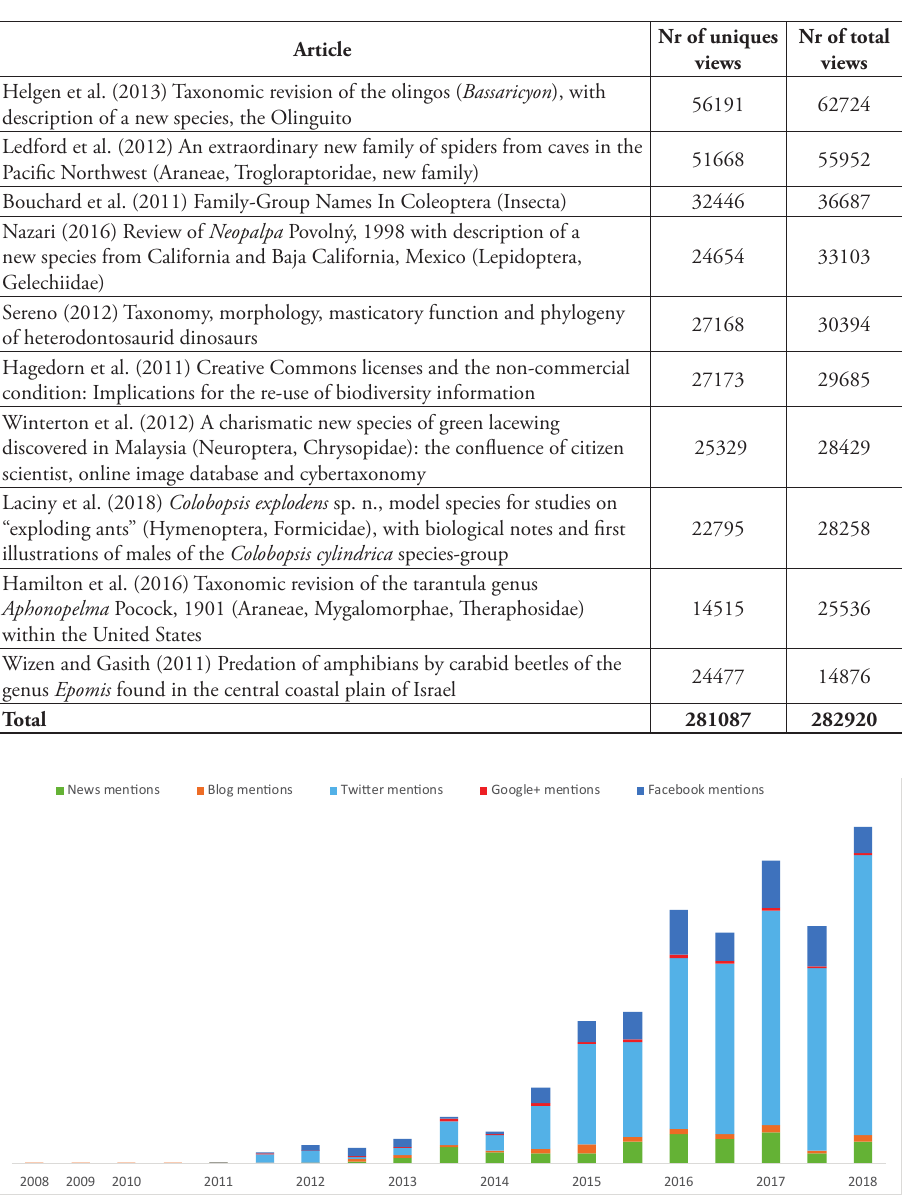
Table 4. ZooKeys articles by number of views.